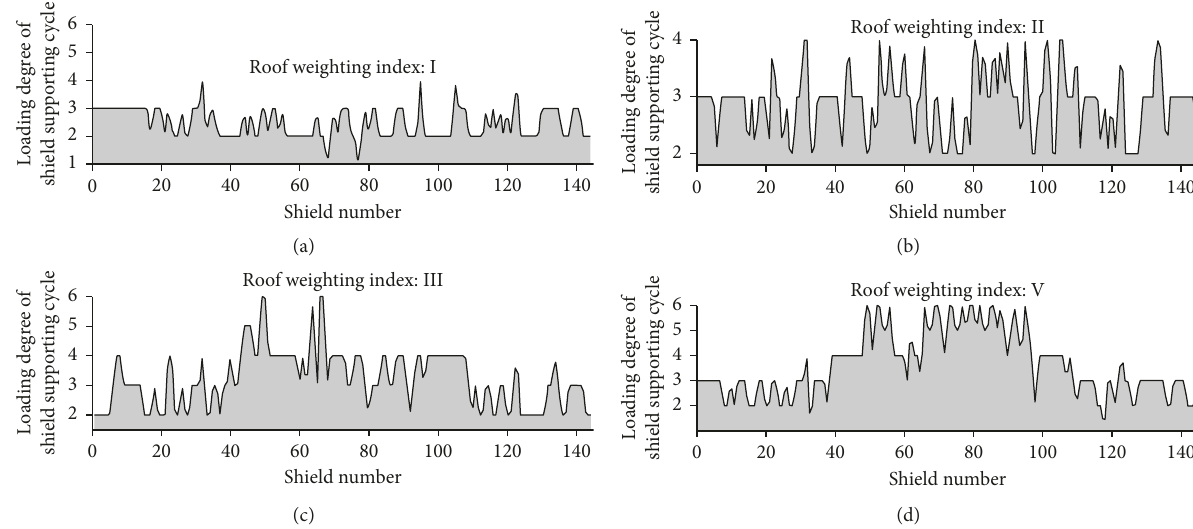
Figure 16: Loading degree of a shield-supporting cycle in different longwall retreating timings. (a) 8 h, (b) 15h, (c) 17.8h, and (d)